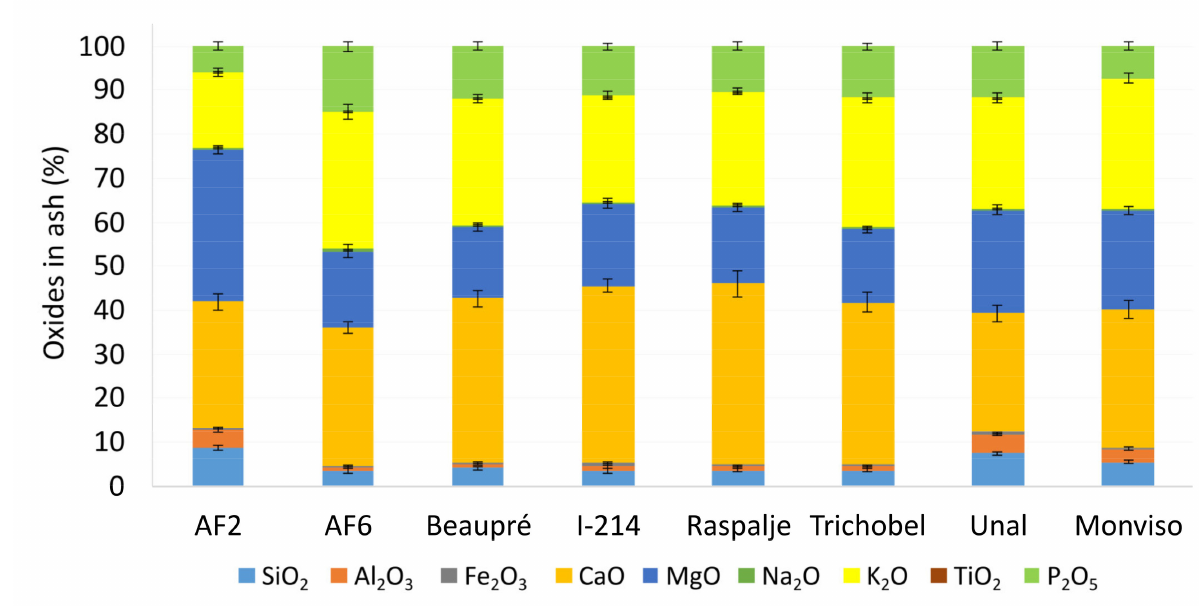
Figure 3. Chemical composition of ash samples by percentage. Errors bars represent ± standard